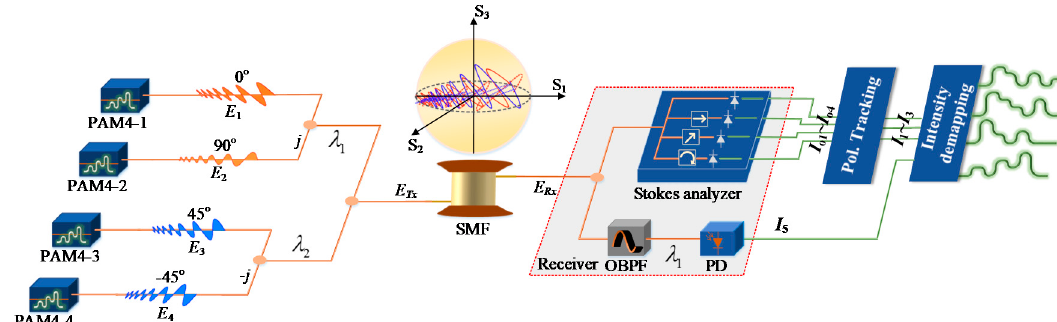
Figure 8. The principle of the simplified detection scheme. PAM: pulse amplitude modulation; SMF: single mode fiber; Pol.: polarization; OBPF: optical band-pass filter; PD, photodetector; (From [103] © 2021 OSA).